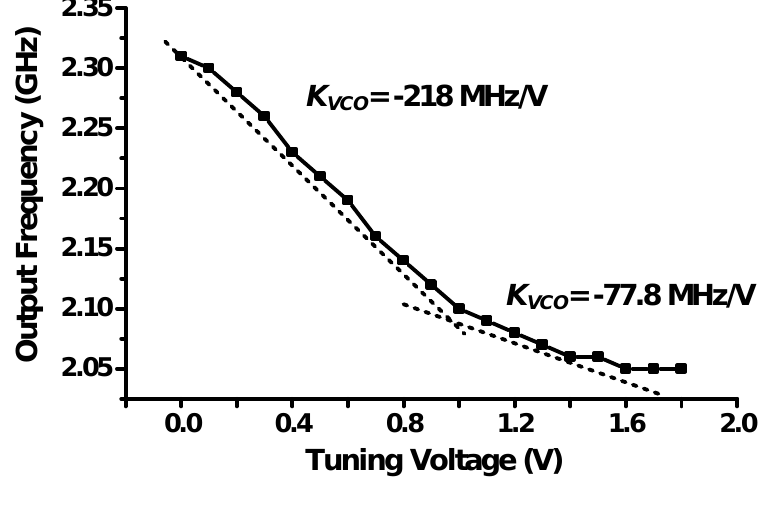
Figure 4. The simulated output frequency of oscillation as a function of the tuning